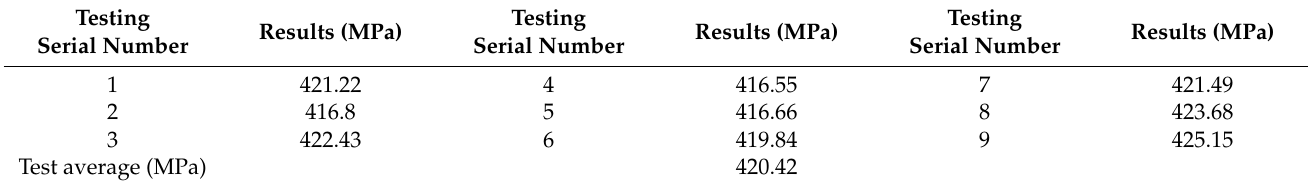
Table 6. Clad rebar bonding performance test